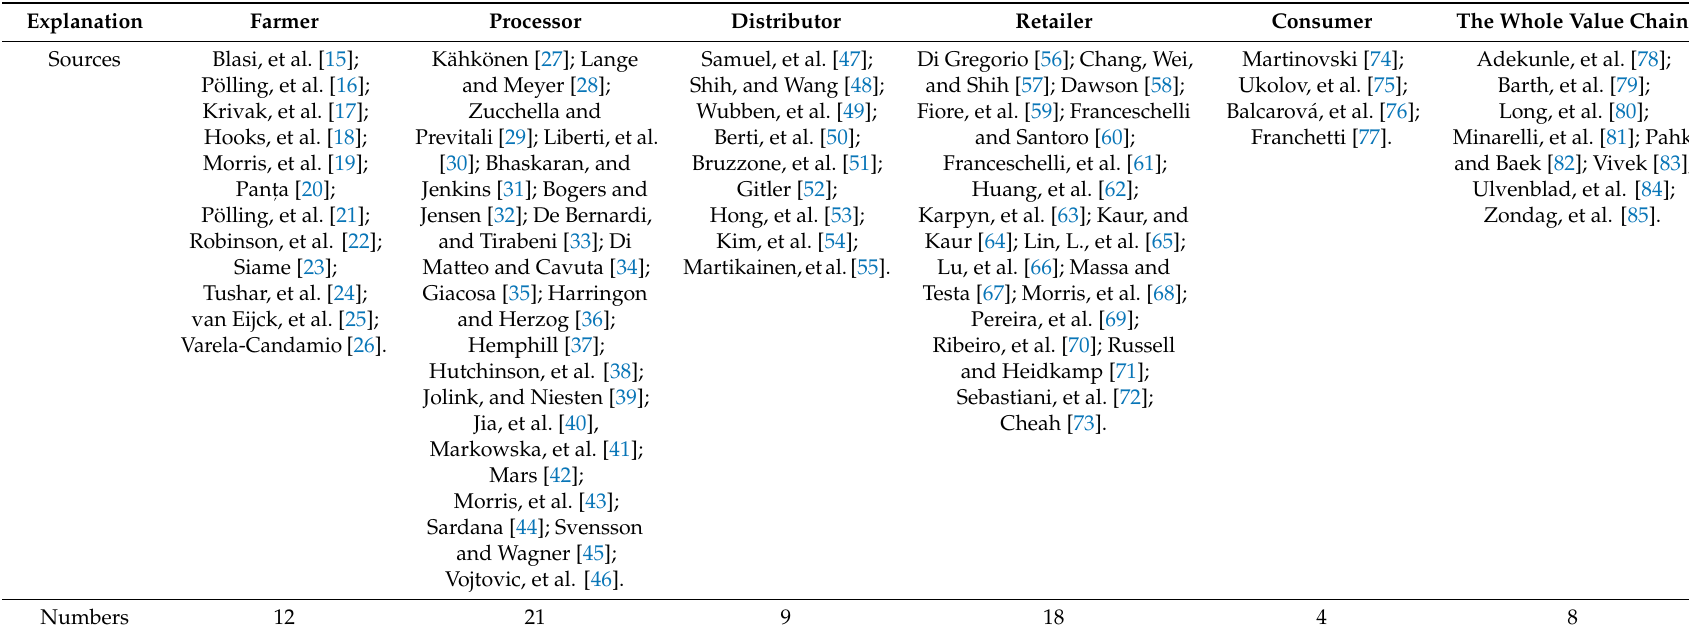
Table 1. Categorizing the reviewed articles based on their focus on the food supply chain (FSC). Explanation Farmer Processor Distributor Retailer